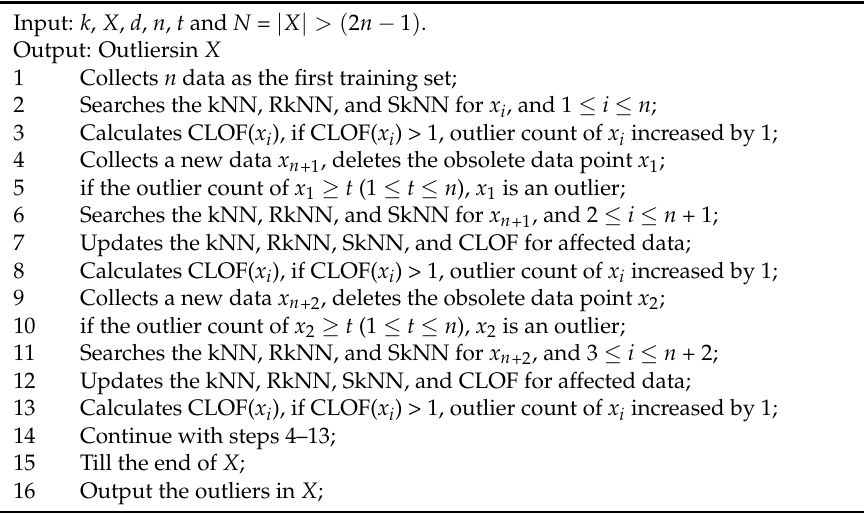
Table 1. The pseudocode of the CNN-based local outlier factor (CLOF)